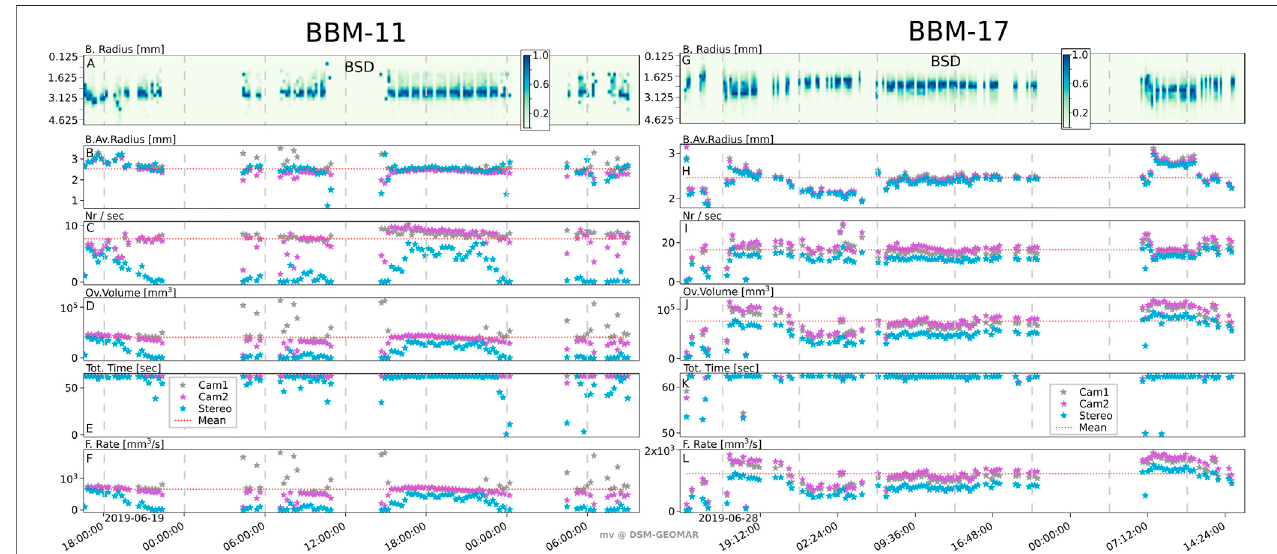
FIGURE 4 | Bubble-Box results versus time including BSD, average sizes, number per time, overall volume, time period of bubble analyses, and fl ow rates. (A – F) Results for BBM-11. (G – L) Results for BBM-17.